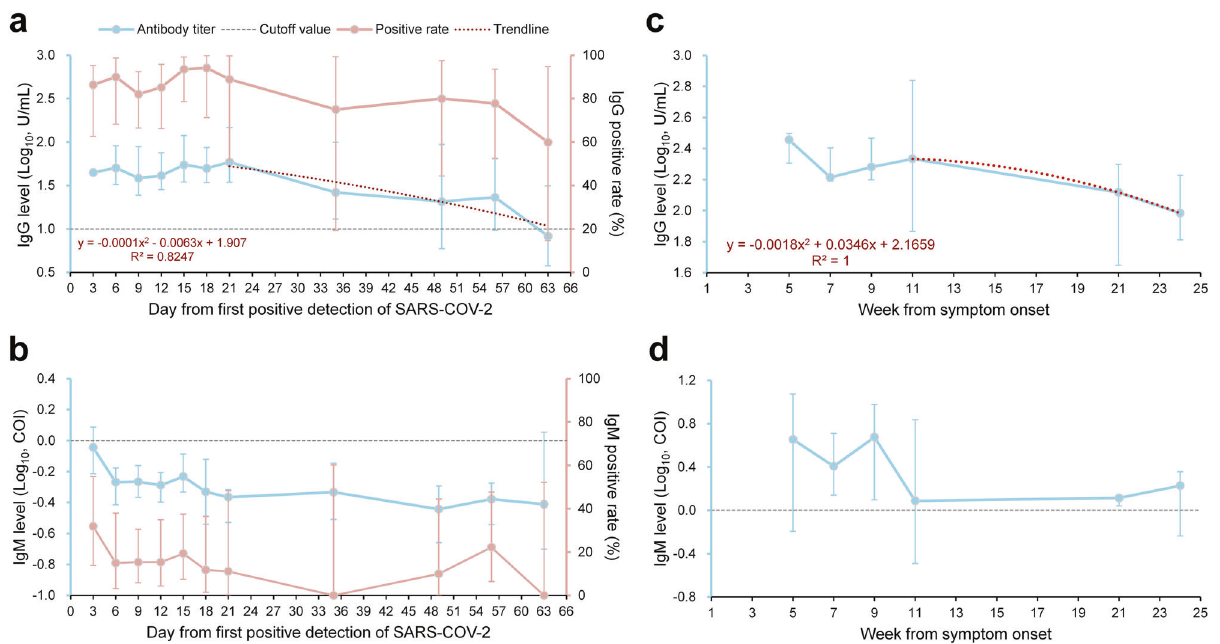
Fig. 2 Dynamic pro fi les of IgG and IgM antibody titers and positive rates in the asymptomatic individuals and persistent COVID-19 patients with SARS-CoV-2 infection. a Dynamic pro fi les of IgG antibody titers (blue line, mean and standard deviation) and positive rates (pink line, rate and 95% con fi dence interval) of the asymptomatic individuals with SARS-CoV-2 infection. The quadratic fi tting curves were performed for IgG antibody titers in the decaying stage; b Dynamic pro fi les of IgM antibody titers (blue line, mean and standard deviation) and positive rates (pink line, rate and 95% con fi dence interval) of the asymptomatic individuals with SARS-CoV-2 infection; c Dynamic pro fi les of IgG antibody titers (blue line, median and interquartile range) of the patients with persistent SARS-CoV-2 infection. The quadratic fi tting curves were performed for IgG antibody titers in the decaying stage; d Dynamic pro fi les of IgM antibody titers (blue line, median and interquartile range) of the patients with persistent SARS-CoV-2